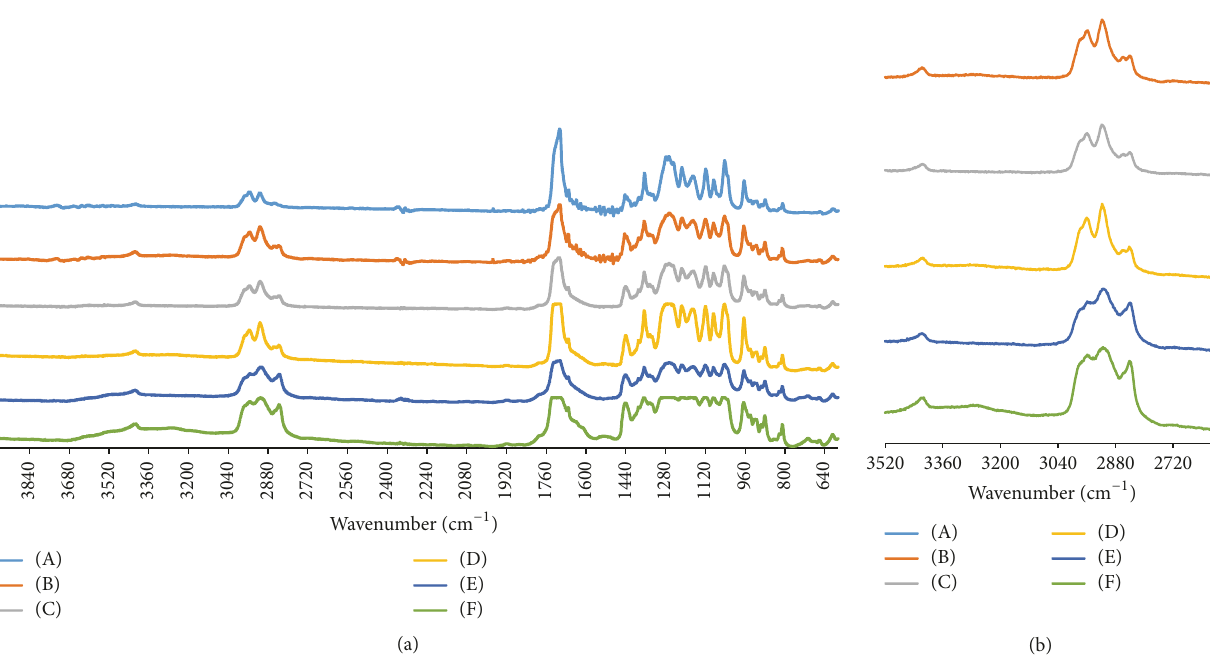
Figure 4: Fourier transform infrared spectroscopy (FTIR) spectra of the poly-R-hydroxyalkanoates (PHAs) produced by the addition of avocado oil: (A) 0 (control); (B) 5, (C) 10, (D) 15, (E) 20, and (F) 25 percent [v/v]. (a) 600 to 4000cm −1 , (b) 2500 to 4000 cm −1 .